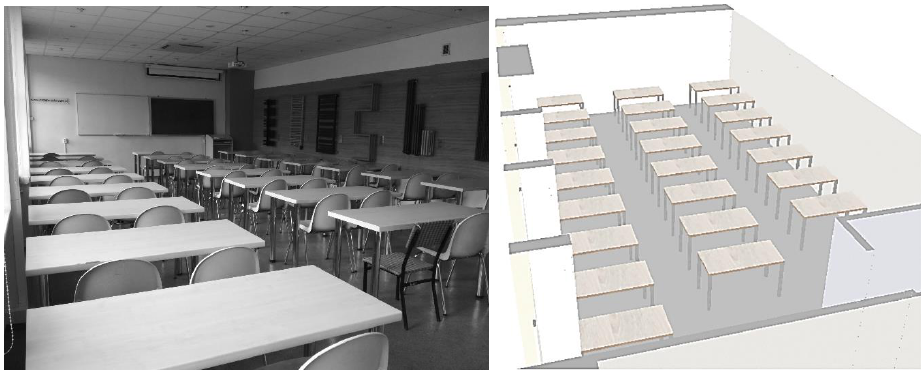
Figure 2. A photograph and visualization of the lecture hall 210. 109